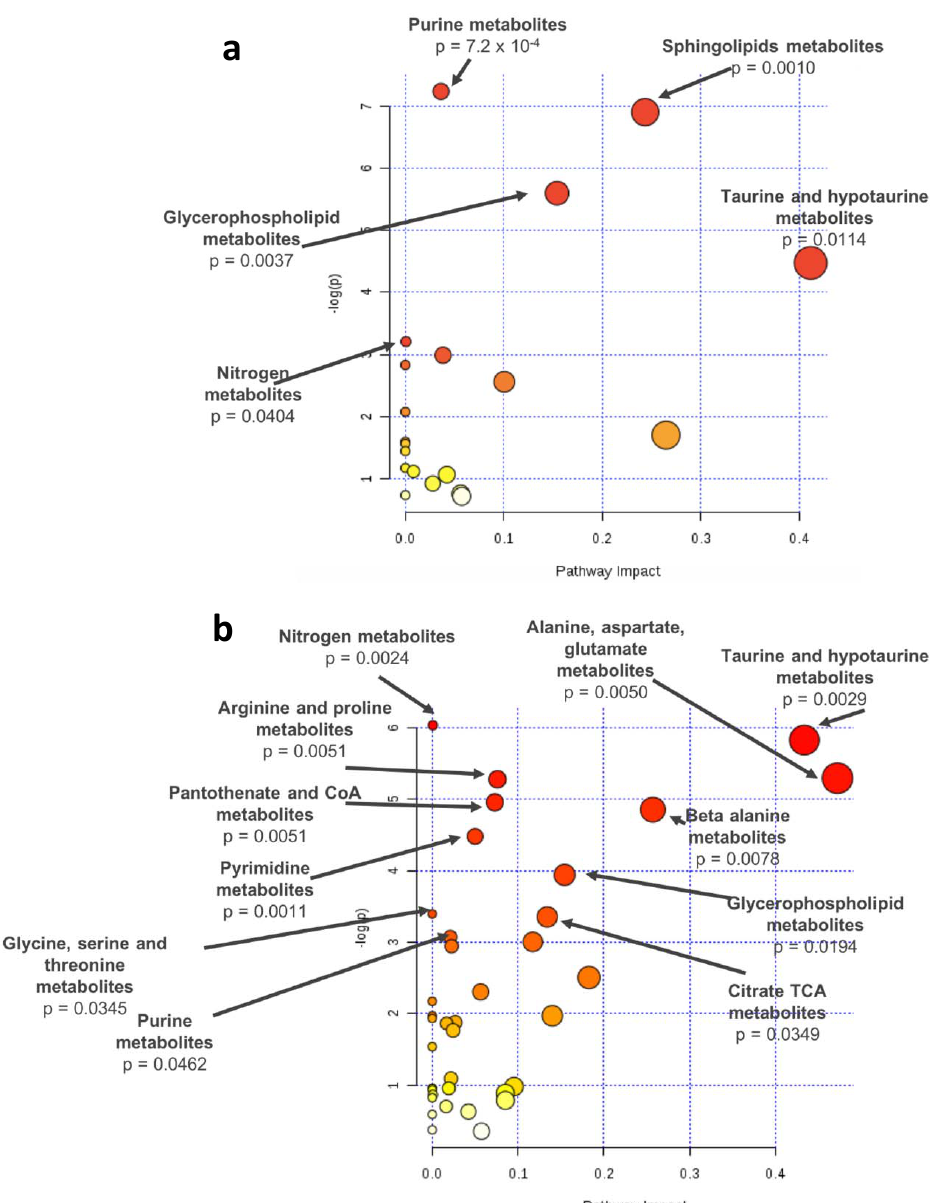
Figure 3. Pathway analysis of the metabolites di ff ering significantly based on q -values ( a ) between AMD patients and controls or ( b ) across stages (controls, early AMD, intermediate AMD, and late AMD), identified by meta-analysis of the results of two study cohorts; -log(p): logarithm of the p